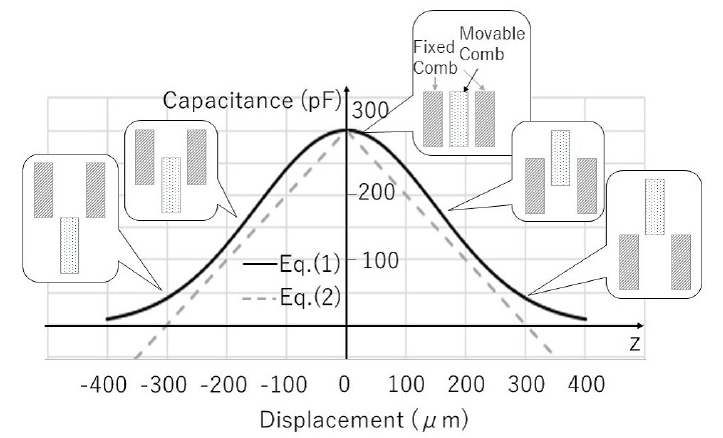
Figure 2. Comparison of the capacitance functions. The fitting parameter z 0 for the Gaussian function form is chosen to be 150 µ m for b = 300 µ